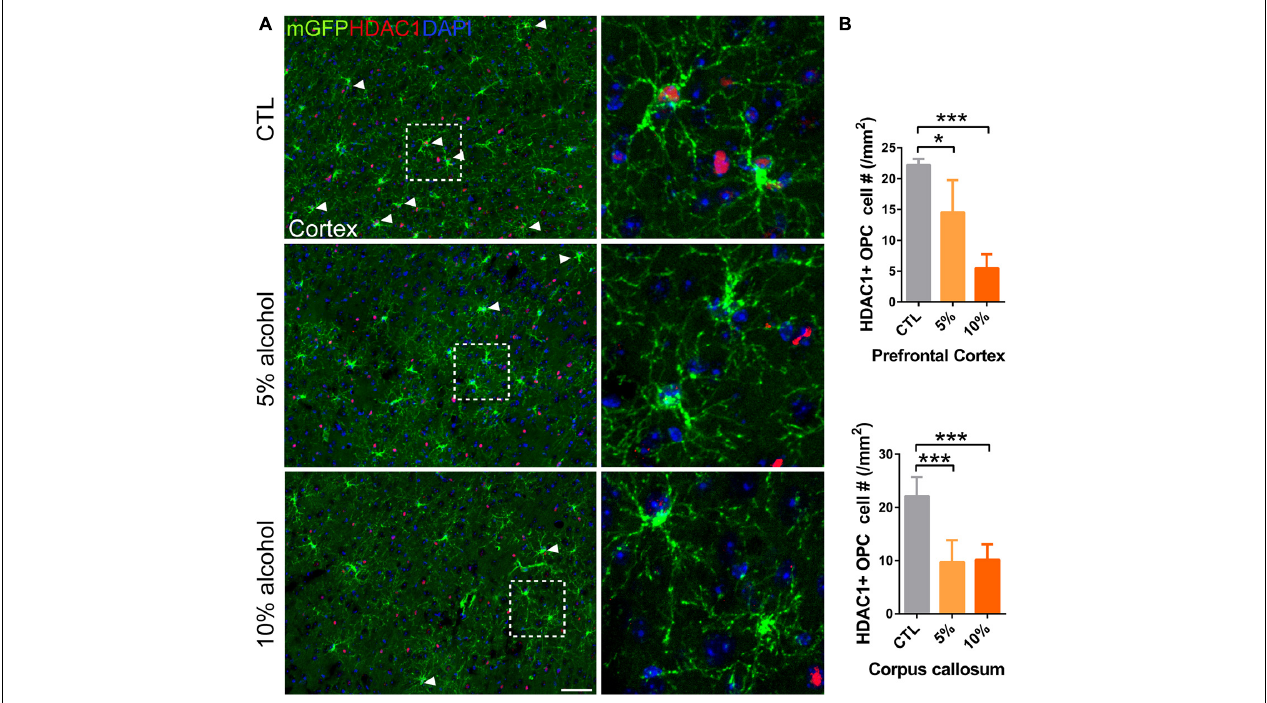
FIGURE 7 | HDAC1 expression is reduced in adult OPCs by alcohol exposure. (A) Immunostaining of HDAC1 showing HDAC1 + GFP + OPCs (arrowheads) was remarkably reduced in the cortex of alcohol-treated mice. The dotted white box was magnified in the right panel. Scale bar 50 µ m. (B) Quantification of HDAC1 + GFP + OPCs in the corpus callosum and prefrontal cortex (* p < 0.05, *** p < 0.001, n = 6).